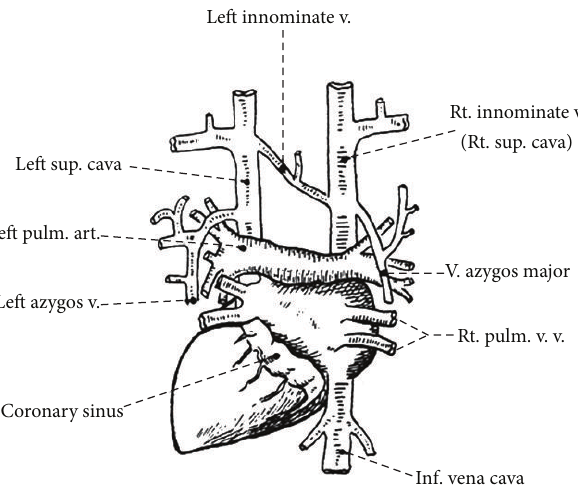
Figure 3: Diagram of the heart and great veins from behind, showing the arrangement in a case of persistence of the left superior cava. Credit: Sharpey-Schafer et al.